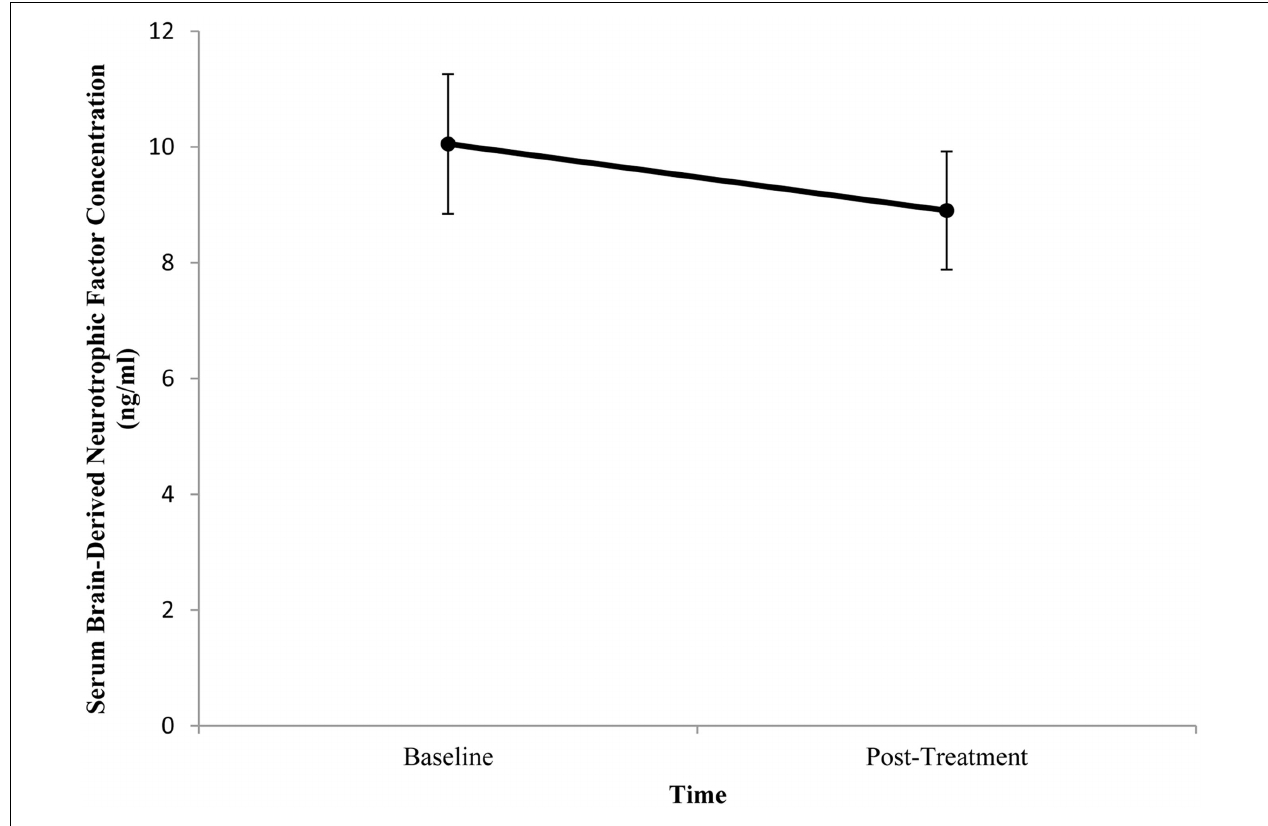
FIGURE 3 | Change in serum brain-derived neurotrophic factor (BDNF) concentration from pre- to post-treatment in patients with major depressive disorder treated with repetitive transcranial magnetic